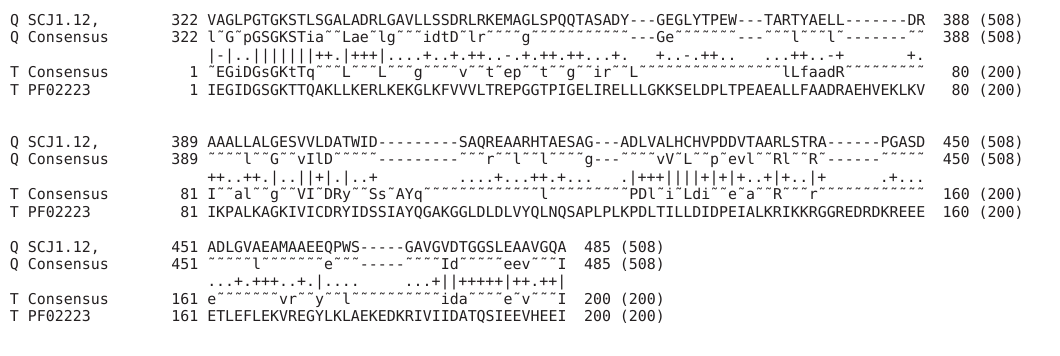
Figure 1: An alignment of SCO0163 (the sequence with the best score), with a representative of the probable thymidylate kinase related cluster UniRef entry